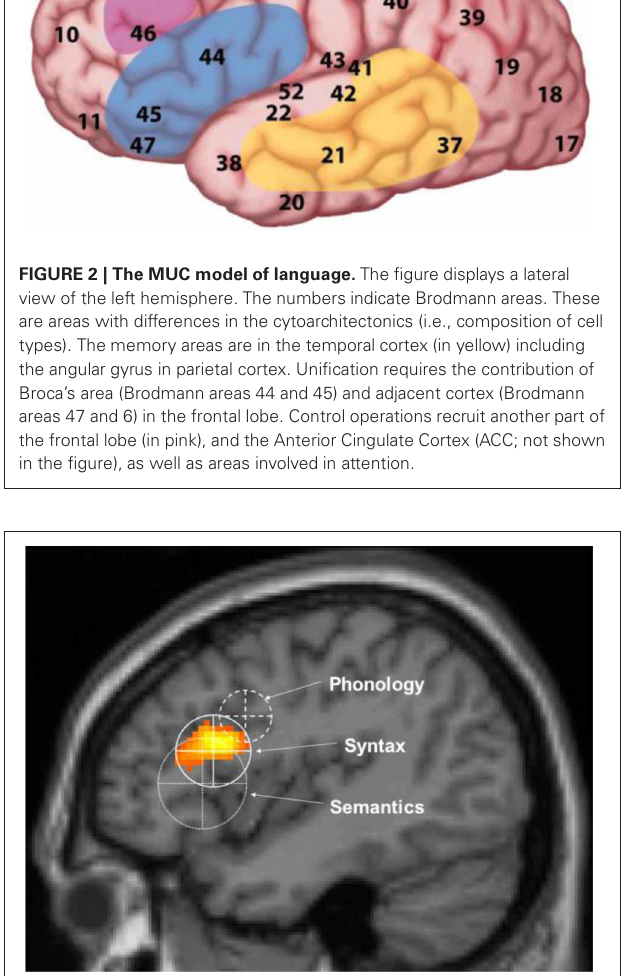
FIGURE 3 | The unification gradient in left inferior frontal cortex. Activations and their distribution are shown, related to semantic, syntactic and phonological processing. Regions are based on the meta-analysis in Bookheimer. The centers represent the mean coordinates of the local maxima, the radii represent the standard deviations of the distance between the local maxima and their means. The activation shown is from artificial grammar violations in Petersson et al. (2004) (courtesy of Karl Magnus